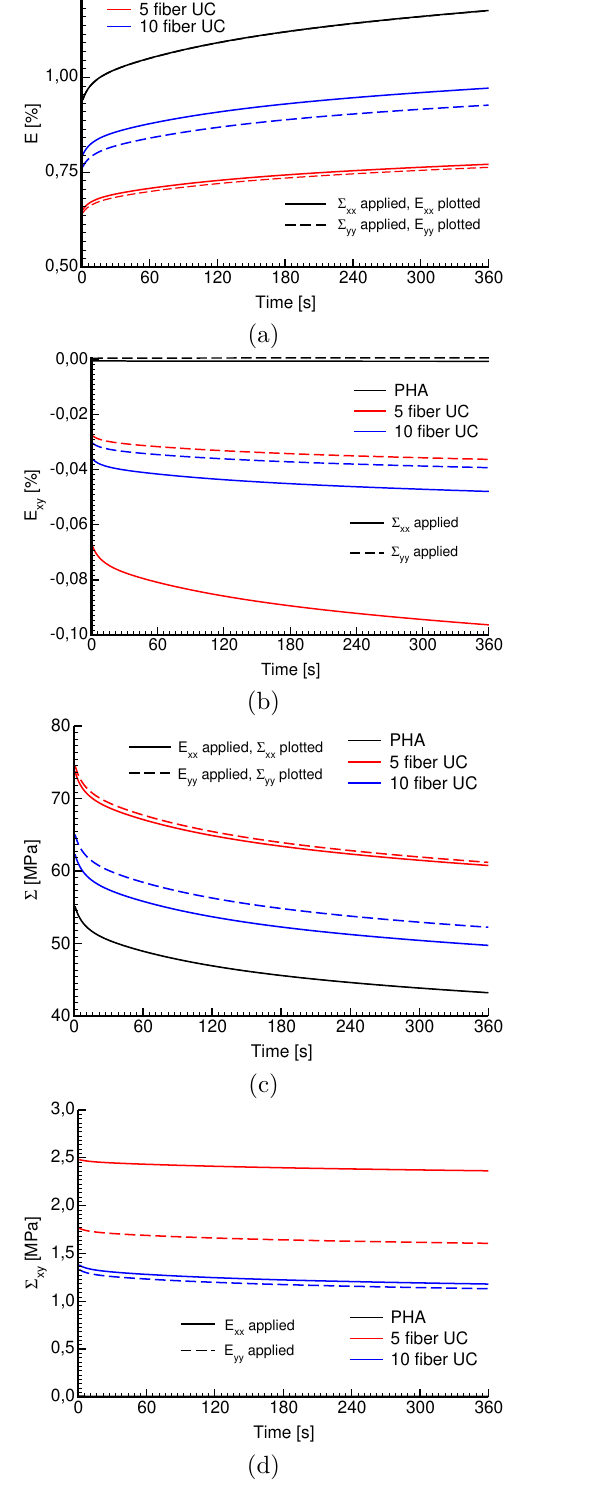
Figure 5. Test of SEPUC applicability: (a-b) creep test - time variation of macroscopic strains due to pre- scribed macroscopic stresses Σ xx , Σ yy , (c-d) relaxation test - time variation of macroscopic stresses due to prescribed macroscopic strains E xx , E yy